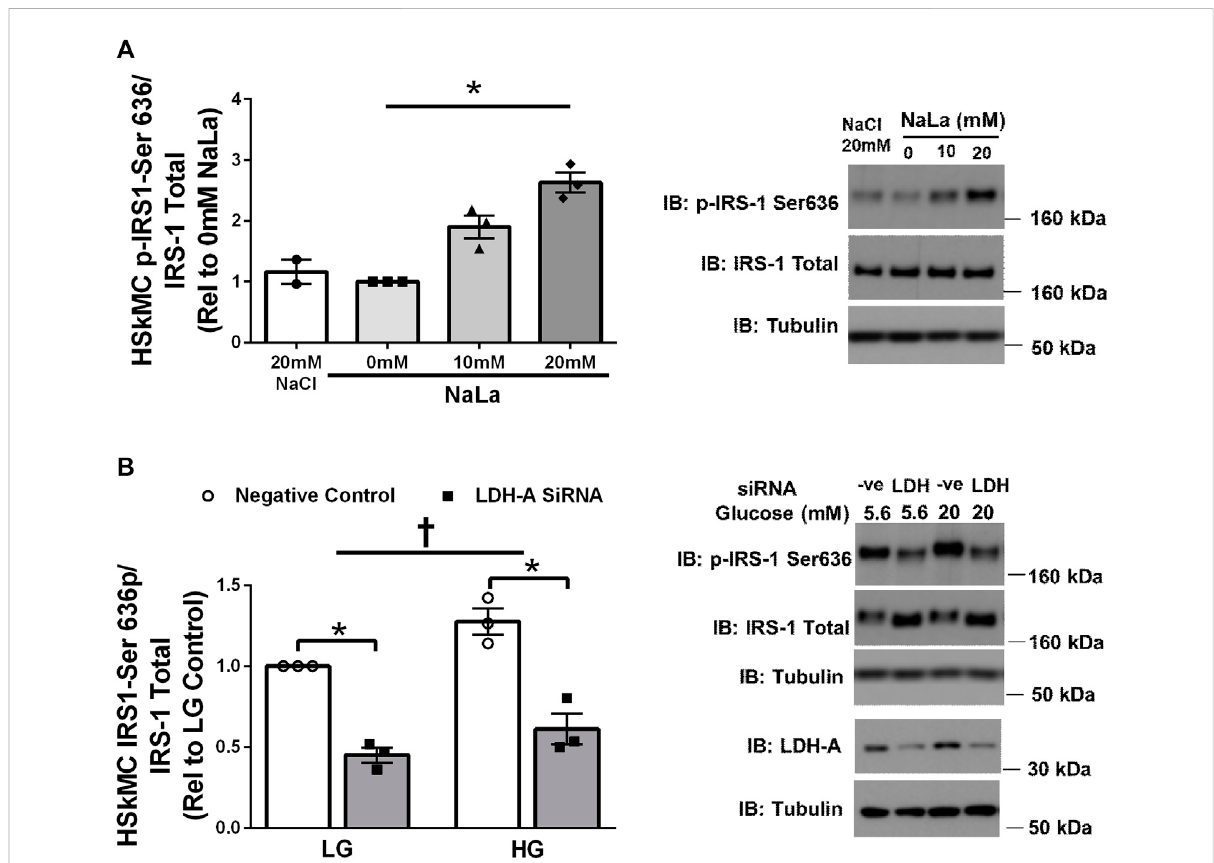
FIGURE 3 Lactate-Induced IRS-1 Serine Phosphorylation on Site 636 in Primary Skeletal Muscle Cells. Quanti fi cation of IRS-1 serine 363 phosphorylation inhumanprimaryskeletalmusclecellsinresponsetoincreasingsodiumlactateconcentrations(n=3forNaLadoseresponse,n=2forNaClcontrol) withrepresentativeblot (A) .Quanti fi cationofphosphorylation onserinesite636inHSkMC inresponsetonegativecontrol (SilencerSelect) andLDH siRNAunderlowglucose(LG,5.6 mmol/L) andhighglucose (HG,20 mmol/L) treatment( n =3)andrepresentativeblot (B)